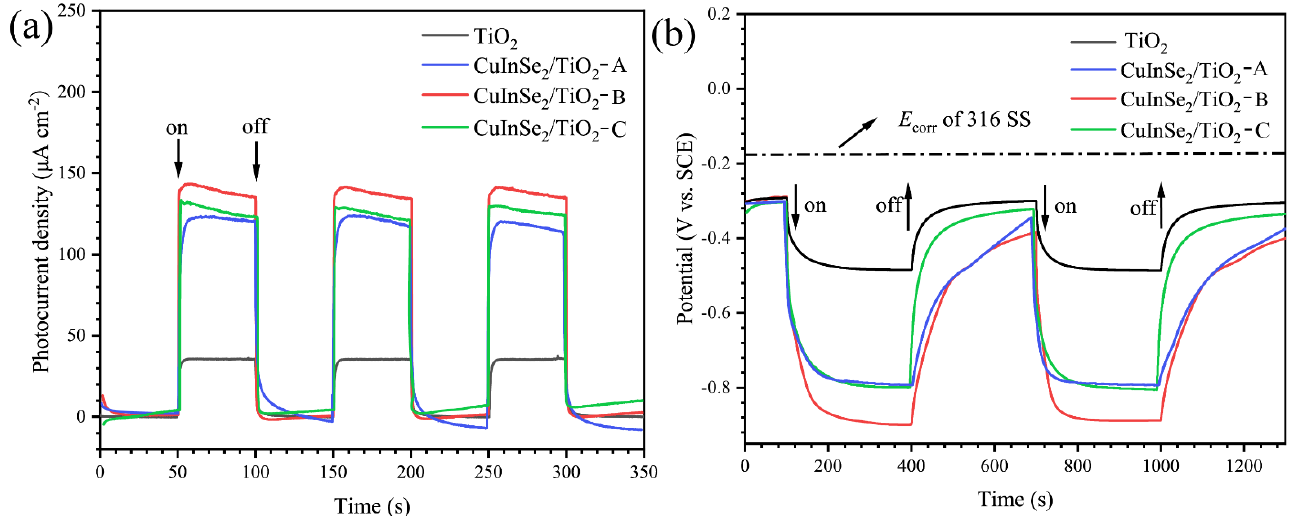
Figure 6. ( a ) I–t curves and ( b ) OCP–t curves between the different materials and 316